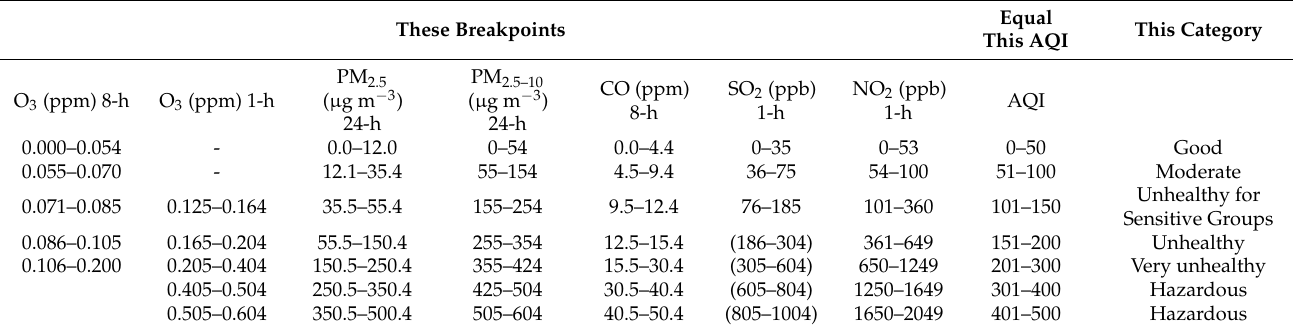
Table 3. Breakpoint Concentration of air pollutants defined by U.S. EPA.